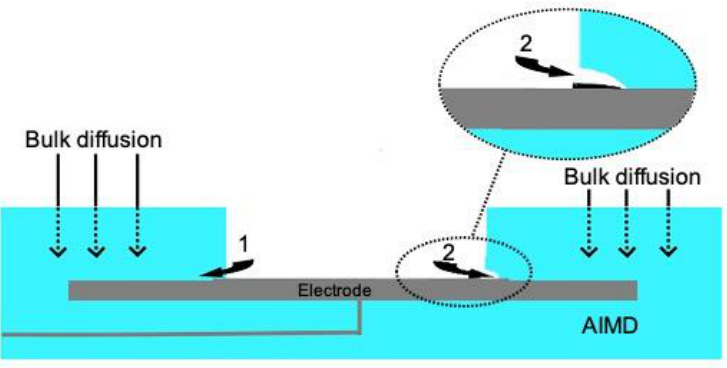
Figure 1. Two processes accelerate delamination in an AIMD: Initially, interfacial diffusion occurs along the metal-polymer interface, which initiates corrosion of the metal surface ( 1 ) Corrosion leads to delamination between the metal surface and the PDMS ( 2 ), creating a cavity shown in detail in the enlargement of ( 2 ). Bulk diffusion additionally intensifies the corrosion